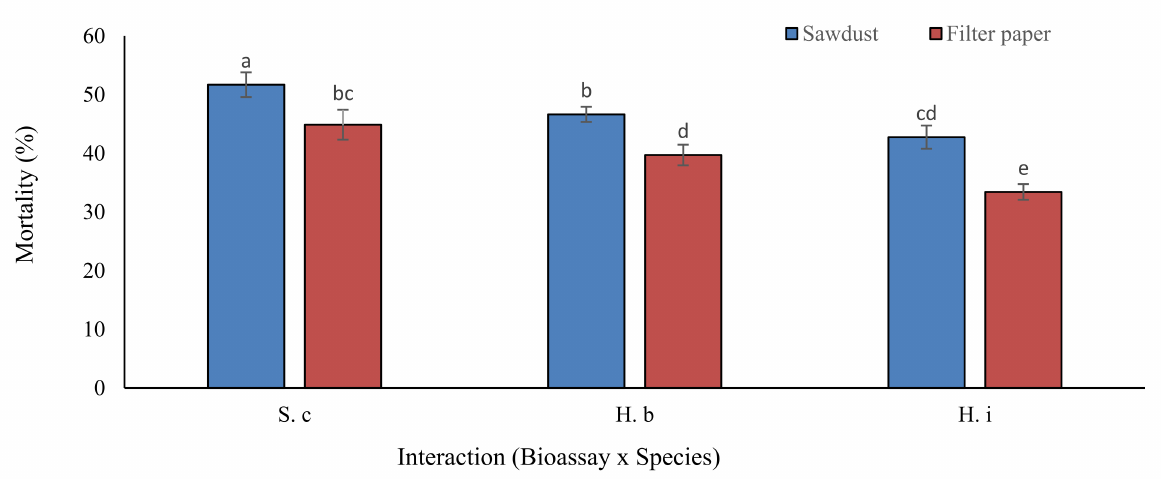
Figure 1. Interactive effect of bioassays × nematode species (B × S) on percentage mortality of Odon- totermes obesus workers kept under laboratory conditions (16 ± 1 ◦ C). Bars with different lowercase letters are significantly different at p ≤ 0.05 (LSD test). Vertical bars indicate standard error (SE) values. S. c: Steinernema carpocapsae ; H. b: Heterorhabditis bacteriophora ; and H. i: Heterorhabditis indica